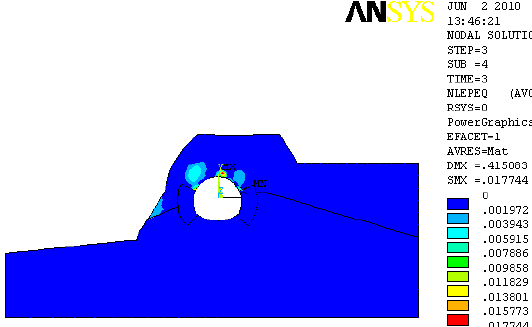
Fig. 6 Distribution of plastic zone of surrounding rock.